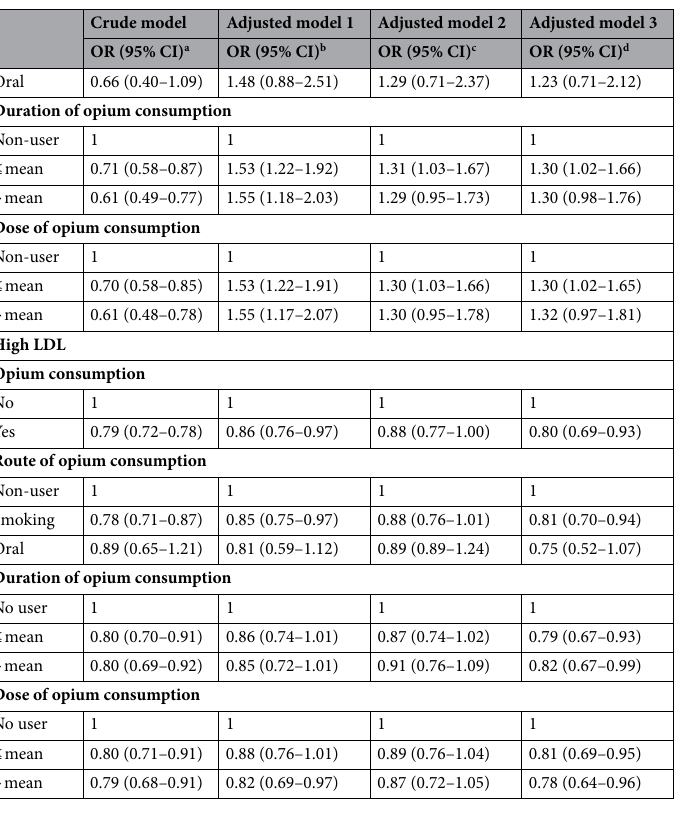
Table 3. Association of opium consumption with Dyslipidemia, High TC, High TG, Low HDL and High LDL in study participants (n = 9932). a The baseline model is stratified on the status of opium consumption. b The adjusted model 1 is adjusted for confounding variables age (continuous variable), gender (male/ female), education years (continuous variable) and wealth status index. C The adjusted model 2 has additional adjustment for confounding variables related to lifestyle (cigarette smoking and alcohol drinking), body mass index (continuous variable) and physical activity level (continuous variable). d The adjusted model 3 has additional adjustment for diabetes (yes/no), hypertension (yes/no), hepatitis (yes/no), renal failure (yes/no), total fat intake (continuous variable), taking hepatotoxic drugs (yes/no) and fatty liver